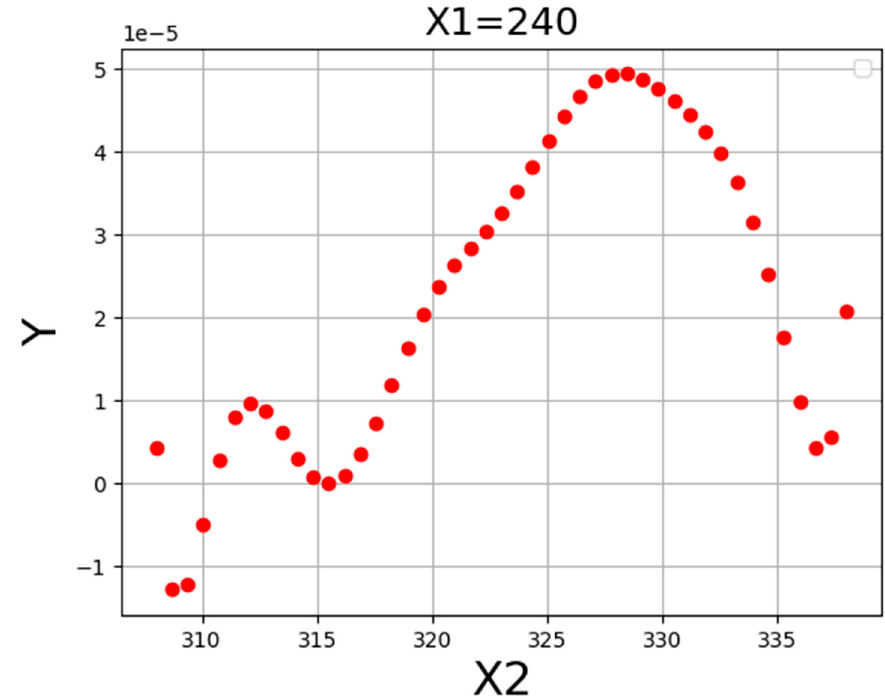
Figure 6. Tendency of X2. Table 3. Modified parameters applying maximum response.